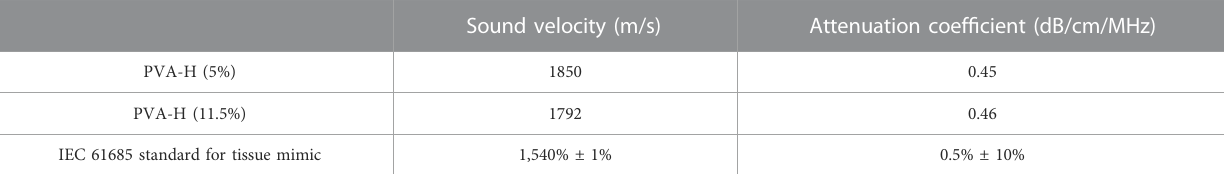
TABLE 1 Sound velocity and attenuation coef fi cient of PVA-H concentration